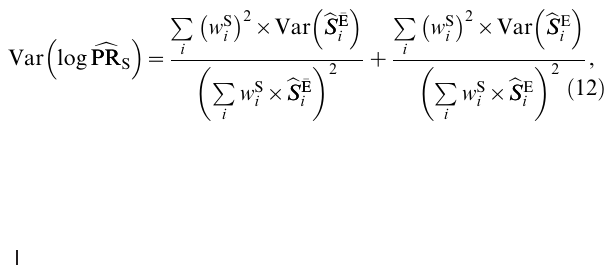
Table 3. Re-analysis of the coronary heart disease (CHD) occurrence data for personality type A and B persons a .